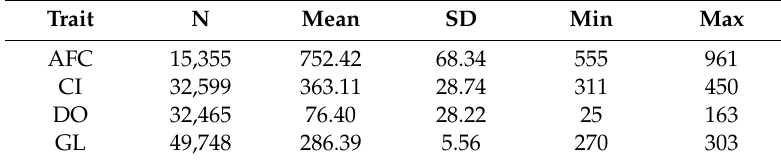
Table 1. Descriptive statistics of the reproductive traits of Hanwoo cows used in this study. Trait N Mean SD Min Max AFC 15,355 752.42 68.34 555 961 CI 32,599 363.11 28.74 311 450 DO 32,465 76.40 28.22 49,748